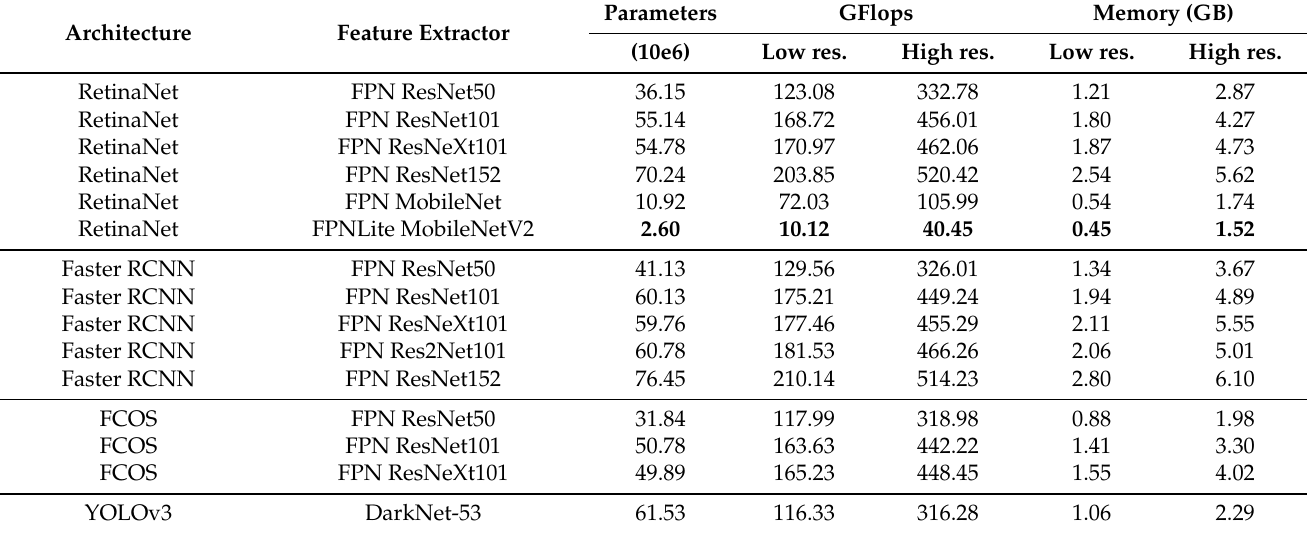
Table 8. Memory usage and number of parameters and flops of all studied